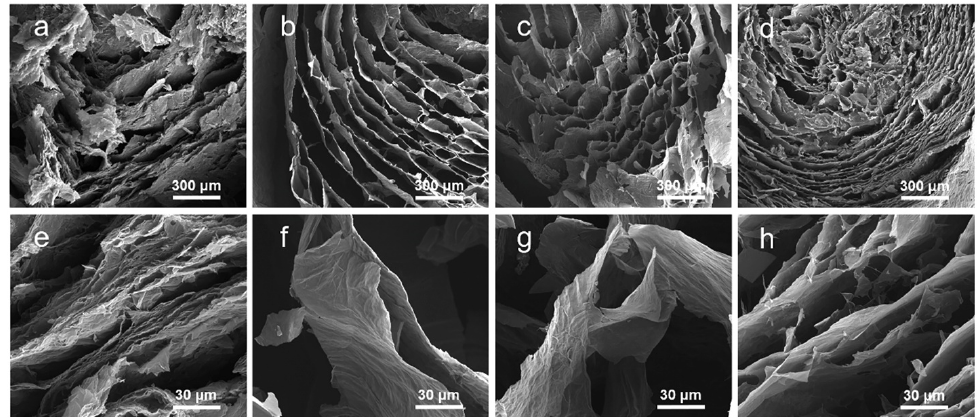
Figure 10. SEM images of the aerogel composites with stratified structures: ( a , e ) prGSBDs, ( b , f ) prGMSBDs-20, ( c , g ) prGMSBDs-10 and ( d , h ) prGMSBDs-5. Reproduced with permission from [40], ©2021 Elsevier B.V.